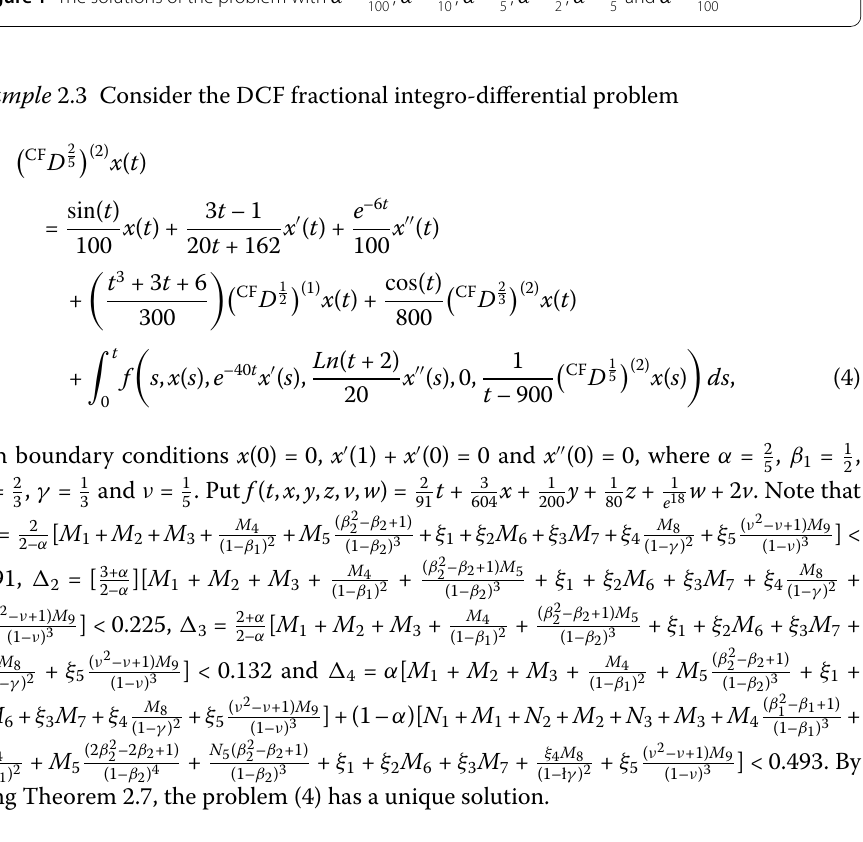
Figure 1 The solutions of the problem with α = 1